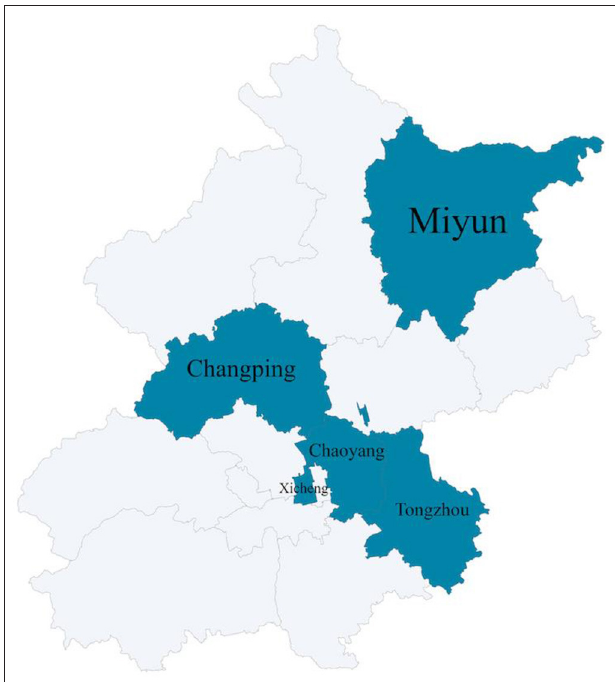
FIGURE 1 | Districts sampling